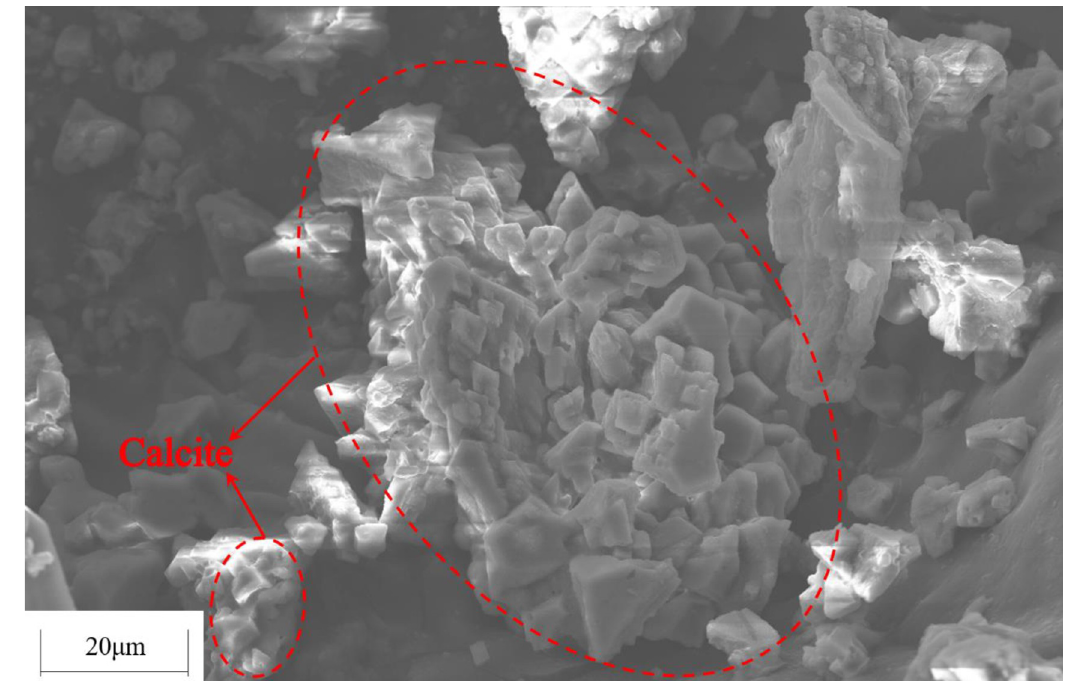
Fig 9. SEM image of the tailings specimen for OD600 =